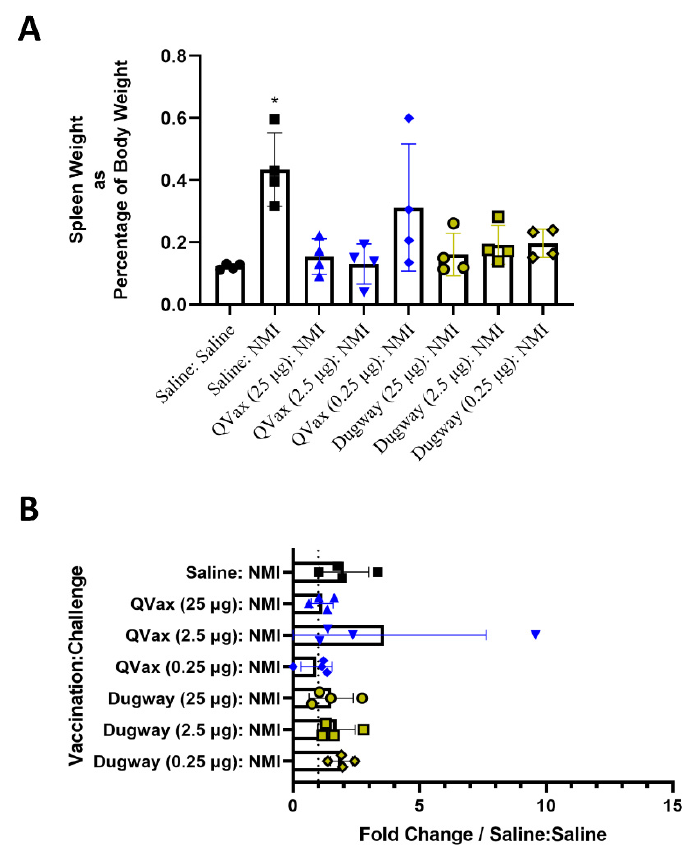
Figure 3. C. burnetii Dugway whole-cell vaccine prevents post-infectious splenomegaly but does not alter bacterial burden. Spleens were weighed at euthanasia (day 14) and splenomegaly was deter- mined by normalizing spleen weight to total body weight ( A ). Splenic bacterial burden at euthanasia is represented by fold change in genome equivalents compared to uninfected (Saline:Saline) animals in ( B ). * p ≤